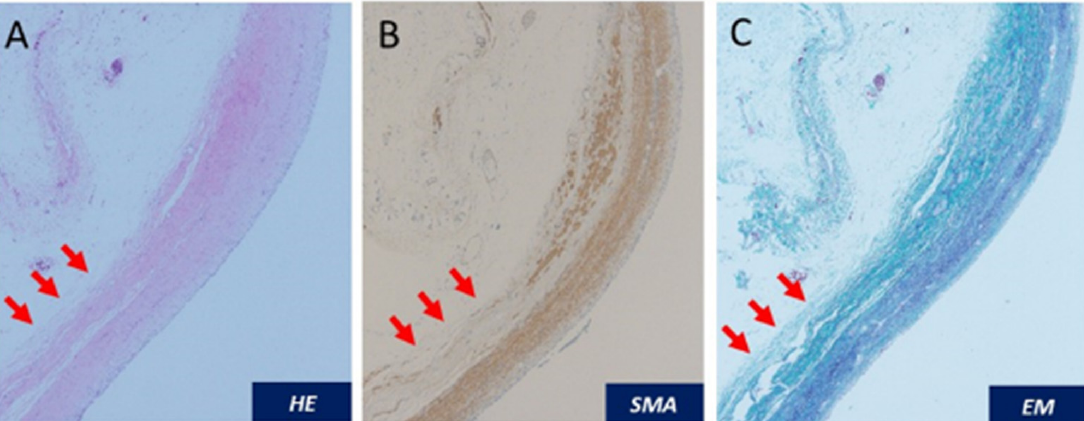
Figure 4. Hematoxylin and eosin (HE) staining at the site of right ureteral stenosis ( A ). The middle circular muscle layer (red arrows) had disruption of smooth muscle cells shown by smooth muscle actin (SMA) staining ( B ) and fibrosis shown by Elastica Masson (EM) staining ( C ).